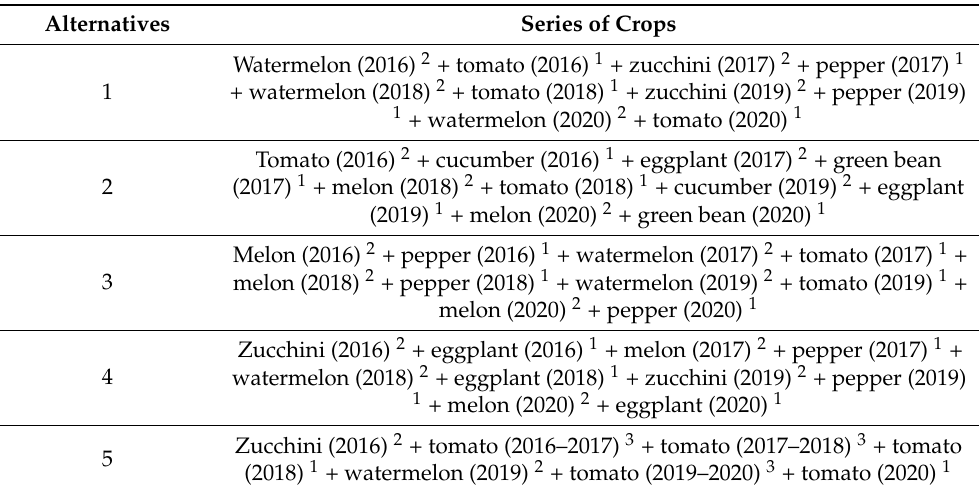
Table 3. Crop alternatives economically evaluated in the 2016–2021 period.